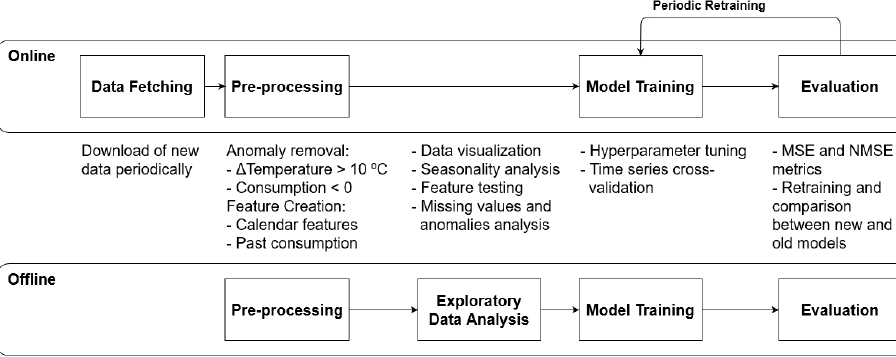
Figure 3. Online and offline pipelines for machine learning